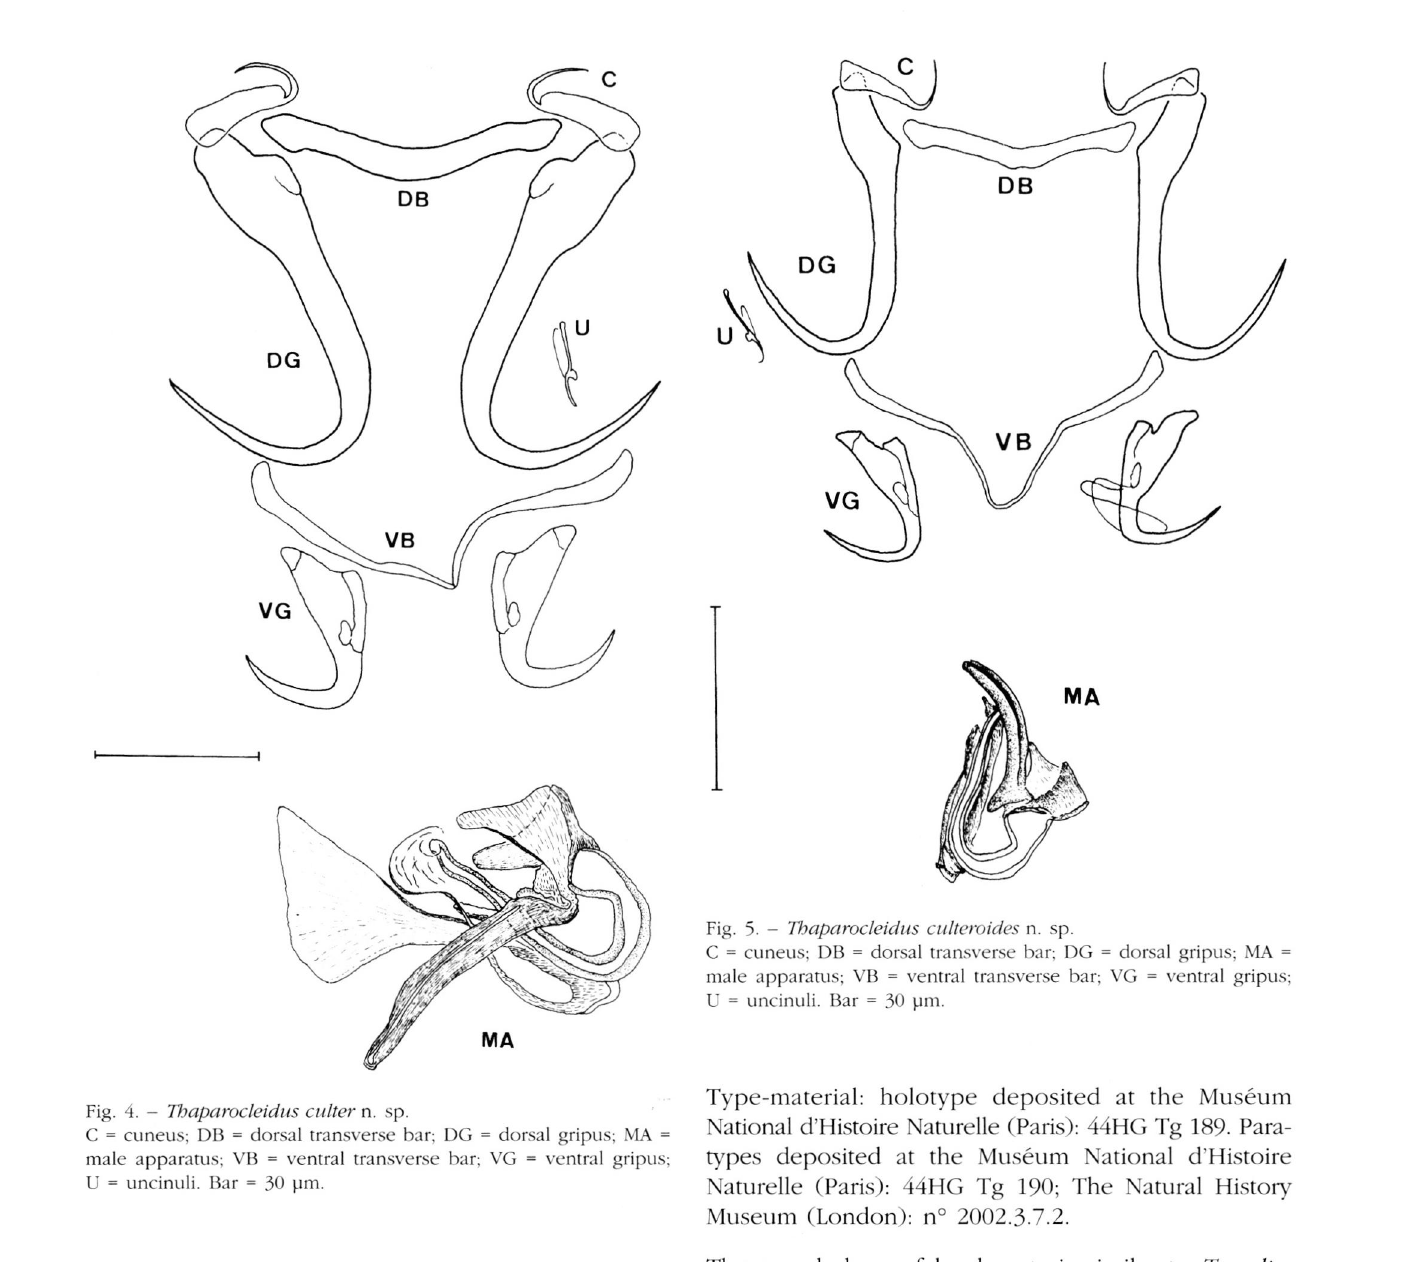
Fig. 5. - Thaparocleidus culteroides n. sp. C = cuneus; DB = dorsal transverse bar; DG = dorsal gripus; MA = male apparatus; VB = ventral transverse bar; VG = ventral gripus; U = uncinuli. Bar = 30